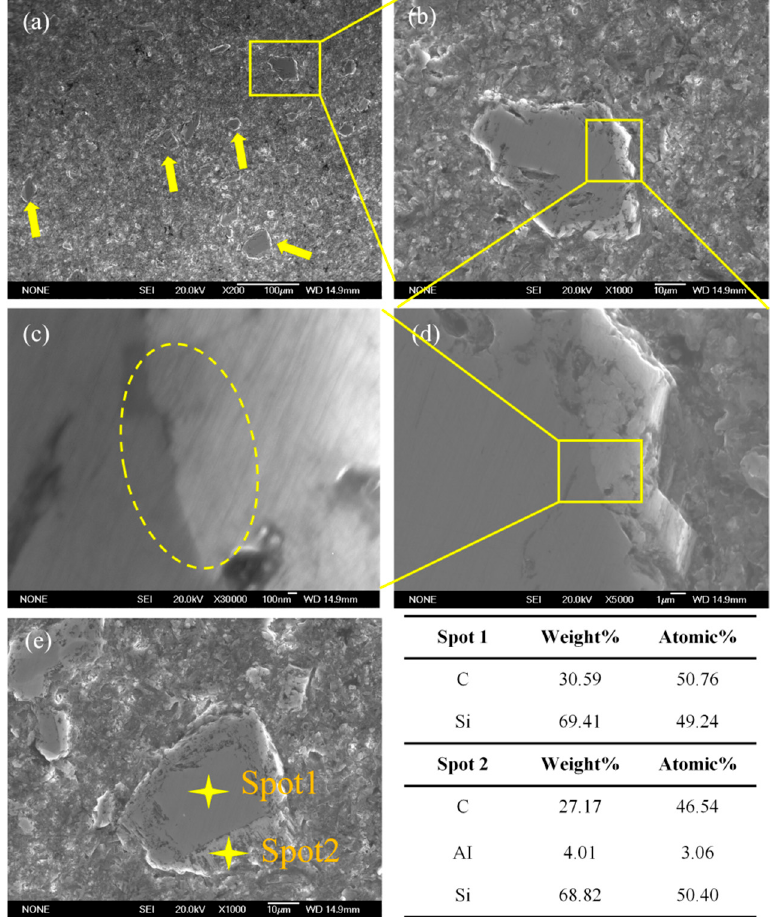
Figure 6. SEM images and EDS point scan analysis of Al-28Si-7C(G1)-5SiC: ( a ) 200X SEM image, ( b ) 1000× SEM image, ( c ) 5000× SEM image, ( d ) 30,000× SEM image, and ( e ) EDS point scan analysis.